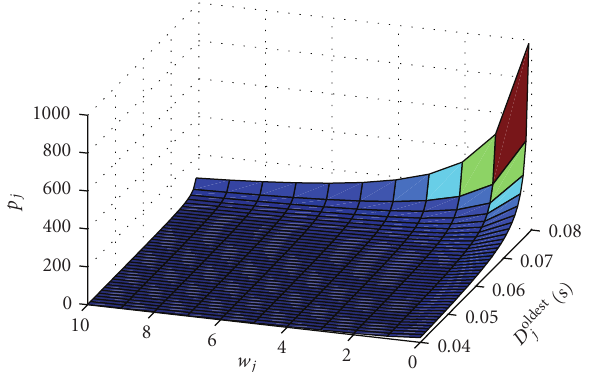
Figure 4: Illustration of p j for RT flows considering D req